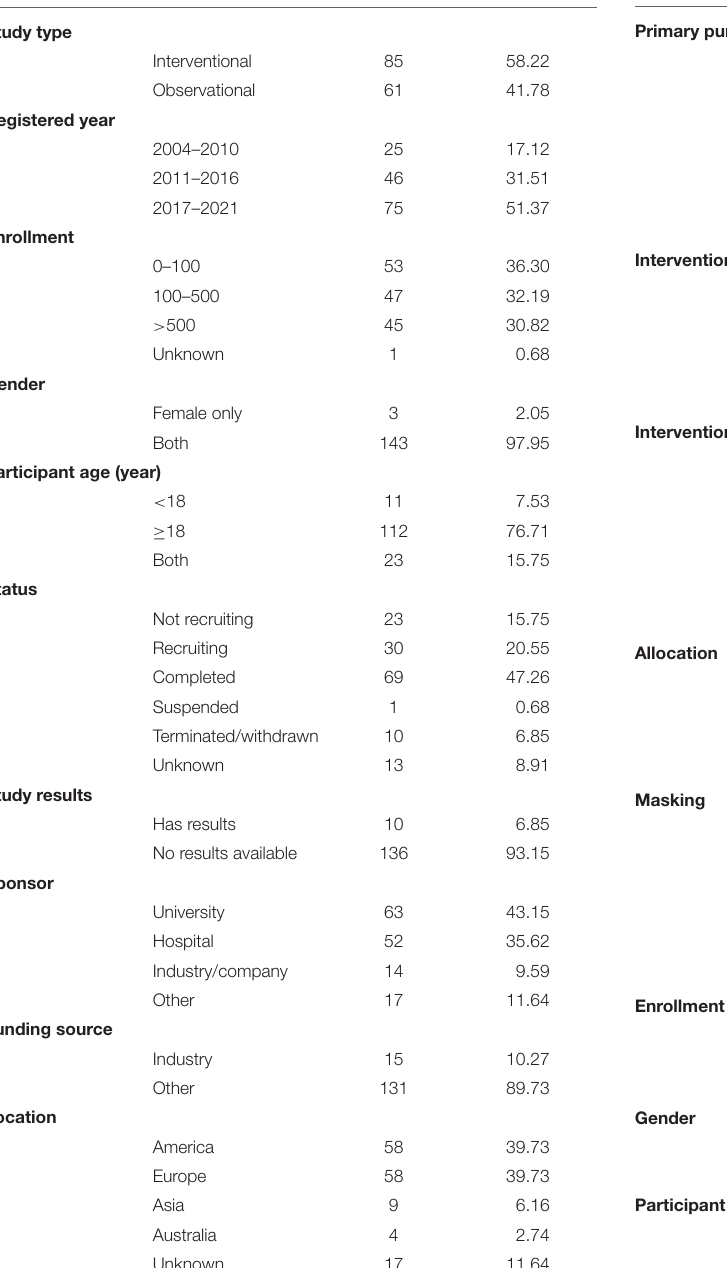
TABLE 1 | The characteristics of the 146 trials registered on ClinicalTrial.gov. Characteristics